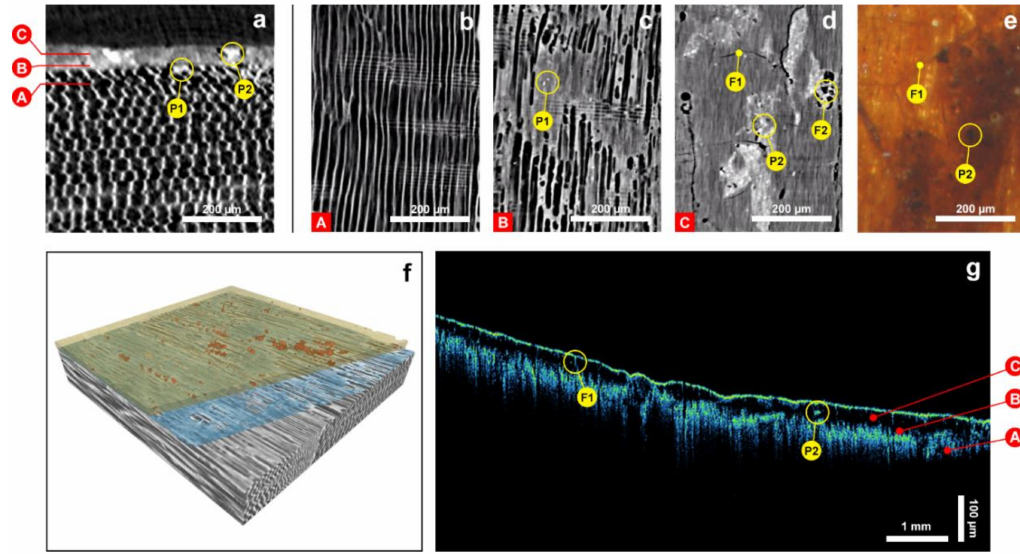
Figure 7. Fragment F21, Lorenzo Guadagnini. ( a ) Transverse slice from the SR-micro-CT volume with the identified layers; the different kinds of particles embedded in the finishing layers are highlighted as P1 and P2. ( b – d ) Radial slices from the SR-micro-CT volume showing the finishing layers discussed in the text and reporting the particles P1 and P2 indicated in ( a ) and identified at different depths. Cracks and air bubbles are indicated as F1 and F2, respectively. ( e ) Stereomicroscopic image of the surface showing the particles P2, embedded in the finishing layers. ( f ) Virtual reconstruction based on SR-micro-CT volume. The preparation layer (B in Figure 7a) is colored in blue and the varnish layer C is shown in yellow with particles colored in red. ( g ) OCT tomogram presented in false-color scale (see Section 2.2 for details). The wood substrate A, the preparation layer, and the varnish layer C are shown. Particles embedded in the varnish and cracks are indicated as P2 and F1,